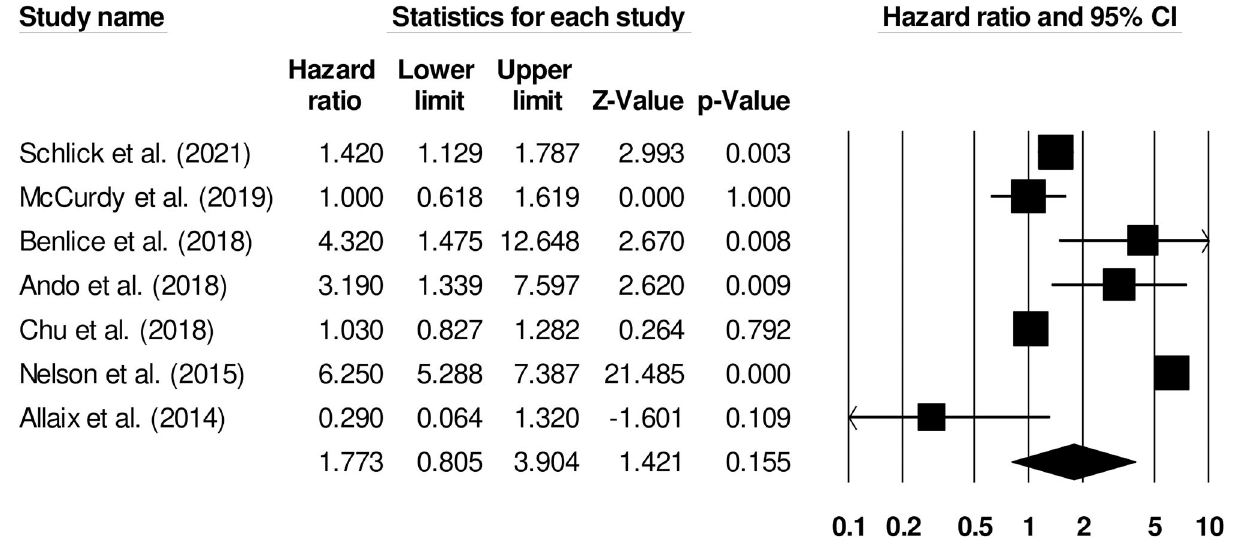
FIGURE 7 | Demonstrates the forest plot for studies evaluating the risk of surgery on venous thromboembolism in patients with inflammatory bowel disease. The hazard ratios are presented as black boxes whereas 95% confidence intervals are presented as whiskers. A small hazard ratio represents lower risks of surgery on venous thromboembolism in patients with inflammatory bowel disease, a higher hazard ratio represents higher risks of surgery on venous thromboembolism in patients with inflammatory bowel disease.